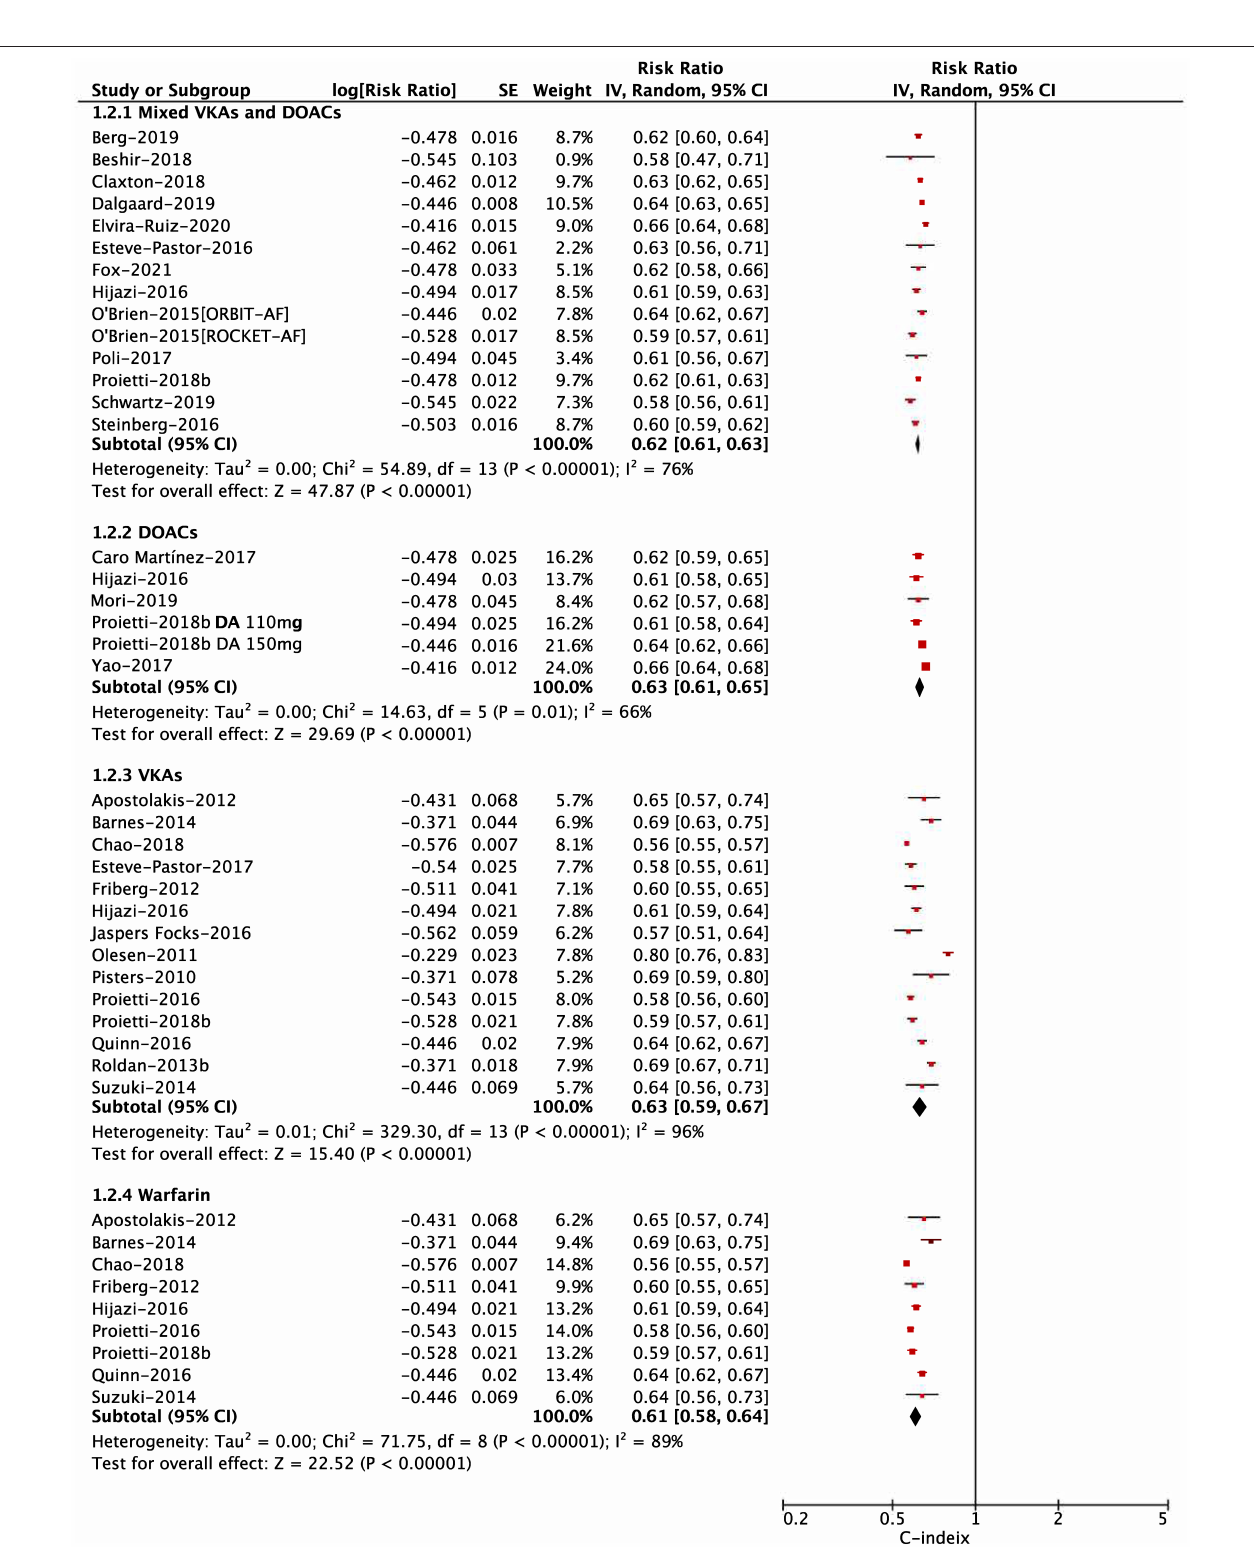
FIGURE 2 | Subgroup analysis for pooling the C-statistic of the Hypertension, Abnormal liver/renal function, Stroke, Bleeding history or predisposition, Labile international normalized ratio, Elderly, Drugs/alcohol concomitantly (HAS-BLED) score based on the types of oral anticoagulation.